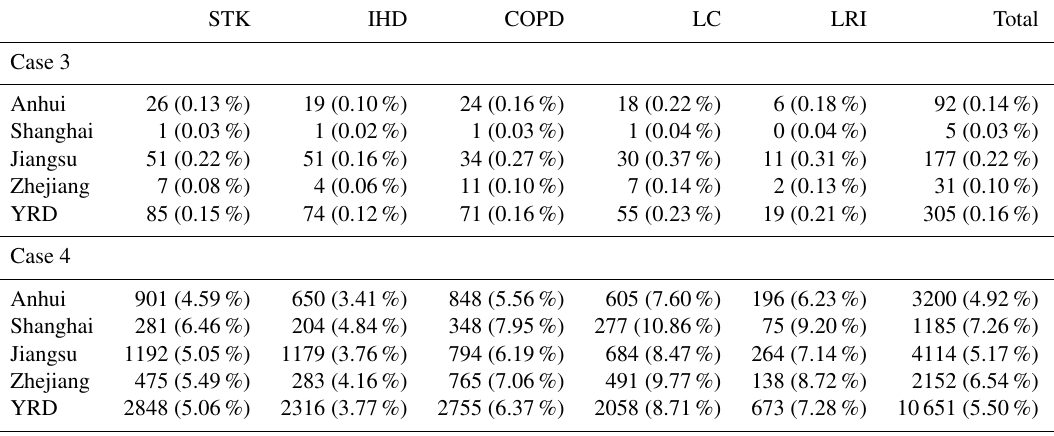
Table 5. The reduced attributable deaths (persons) and rates (in parentheses) resulting from implementation of the ultra-low emission policy in the YRD region.